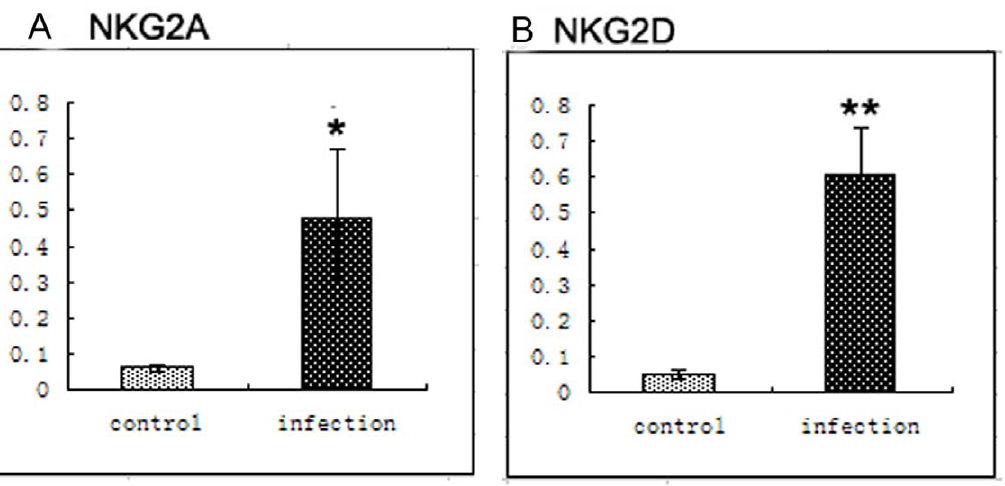
Figure 4. Levels of NKG2A and NKG2D mRNA expression in mice. After 12 h, 24 h, 36 h, 48 h, and 60 h of infection, the levels of (A) NKG2A and (B) NKG2D mRNA expression in uninfected and infected dNK cells were analyzed by real-time PCR (n=15, *p , 0.05, **p , 0.01).